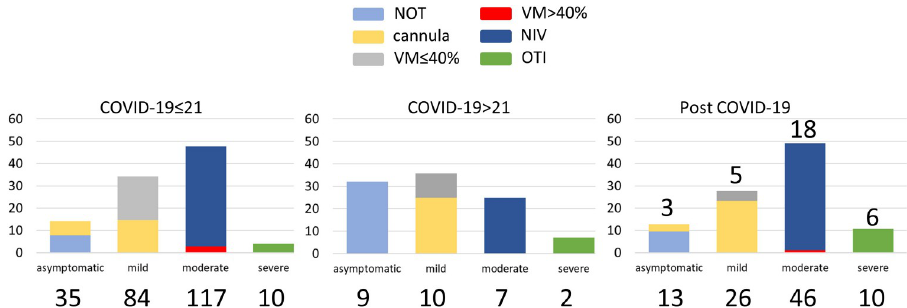
Fig 1. Clinical classification. Distribution (%) of the subjects according to the 4 descriptors defining disease severity in the acute phase, i.e. asymptomatic, mild, moderate and severe. Treatments are indicated by color code: no oxygen therapy (NOT; cyan), nasal cannula (yellow), Ventimask (VM, FiO2 � 40%, grey), VM (FiO 2 > 40%, red), non invasive ventilation (NIV, blue), orotracheal intubation (OTI, green). In the right panel, the numbers above each bar indicate the number of subjects with CT abnormalities at the follow-up visit. In all panels the absolute numbers of subjects are indicated below each bar.